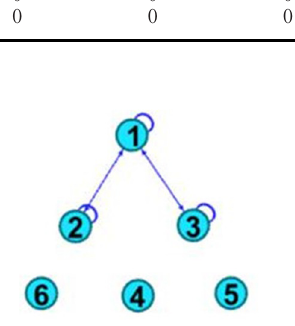
Table 4. Mapping matrix of cross-domain knowledge exchange relationships